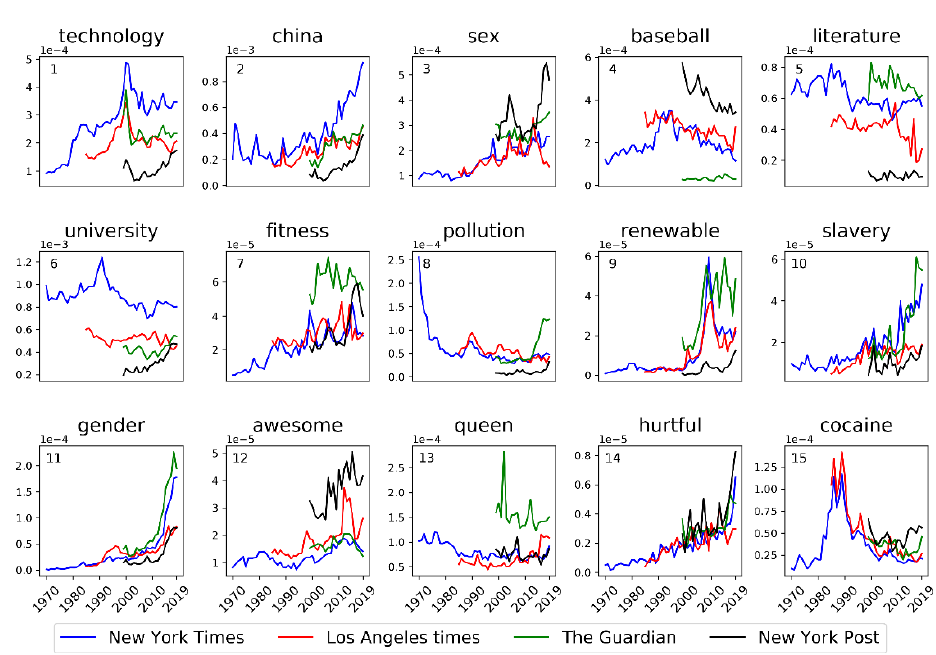
Fig. 2. Absolute yearly frequencies of several words across four different news media